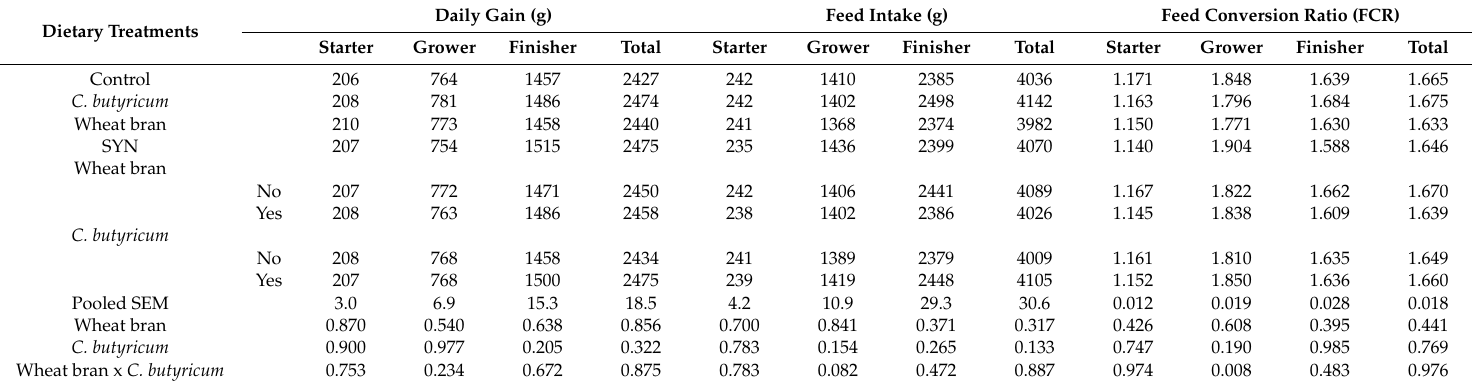
Table 3. E ff ect of wheat bran and Clostridium butyricum ( C. butyricum ) supplementation on growth parameters in broiler chickens (from day 0 to day 37 of age) 1 . Daily Gain (g) Feed Intake (g) Feed Conversion Ratio (FCR) Dietary Treatments Starter Grower Finisher Total Starter Grower Control